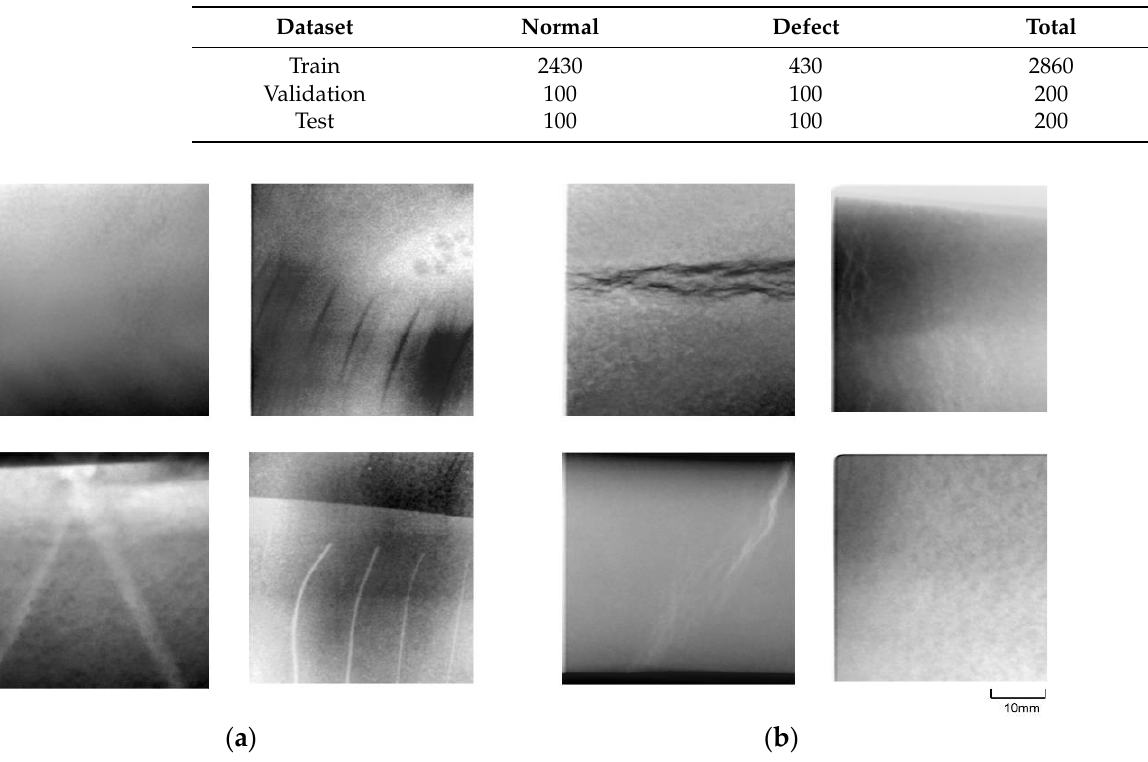
Figure 4. ( a ): normal samples ( b ): defect samples. Table 1. The number of samples in this dataset.